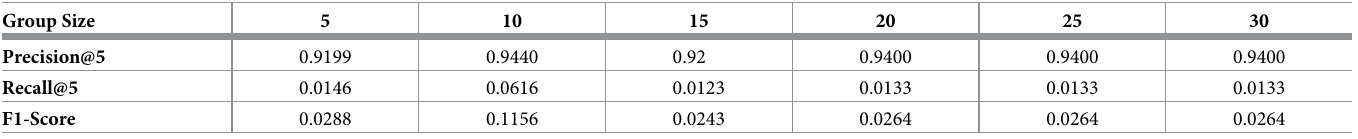
Table 17. Performance of SVD by varying group